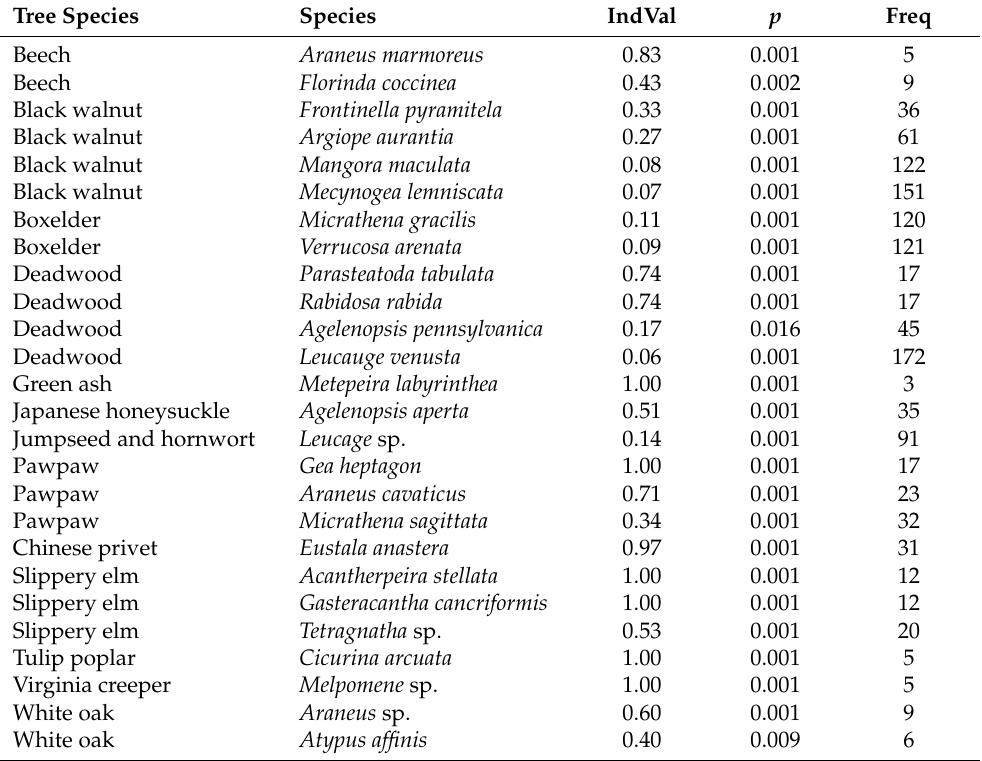
Table 3. IndVal analysis of species that were associated with specific tree species. Specimens were collected in the summer of 2022. Only significant ( p < 0.05) habitat associations are presented. The significance of IndVal indices was assessed using 10,000 Monte Carlo